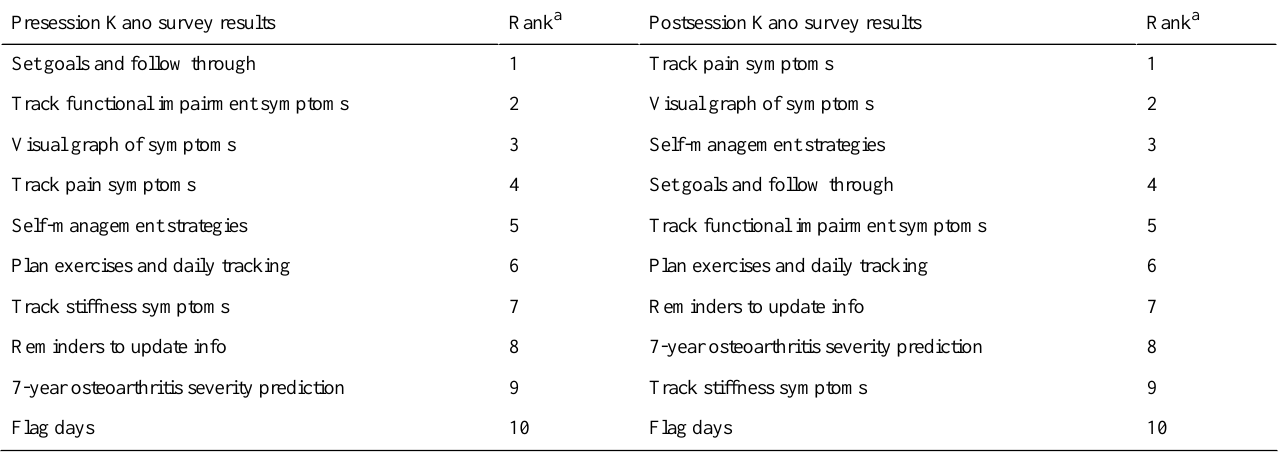
Table 5. Functional requirement importance ranking: presession and postsession 3 Kano